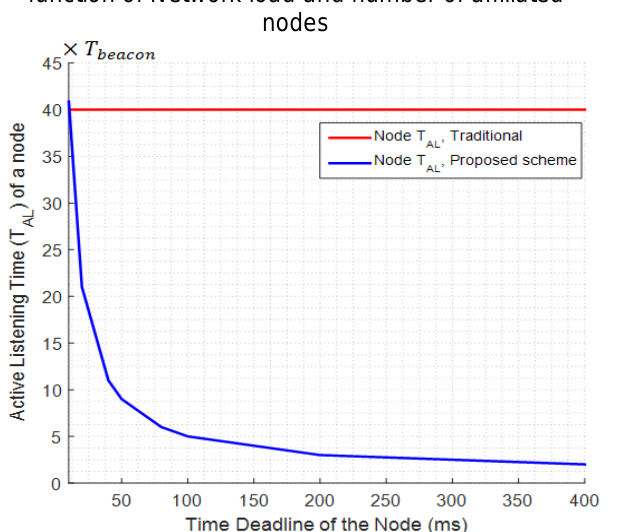
Figure 5. Scheduled slots per sub-frame as a function of Network load and number of affiliated nodes